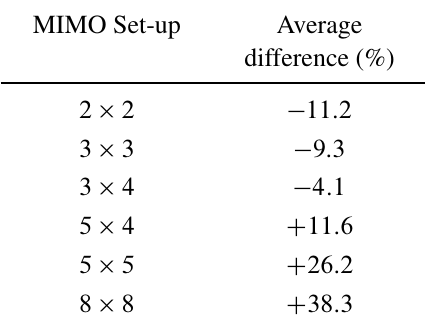
Table 8. BER performance variation of different MIMO blocks compared to a 4 (cid:2) 4 set-up.